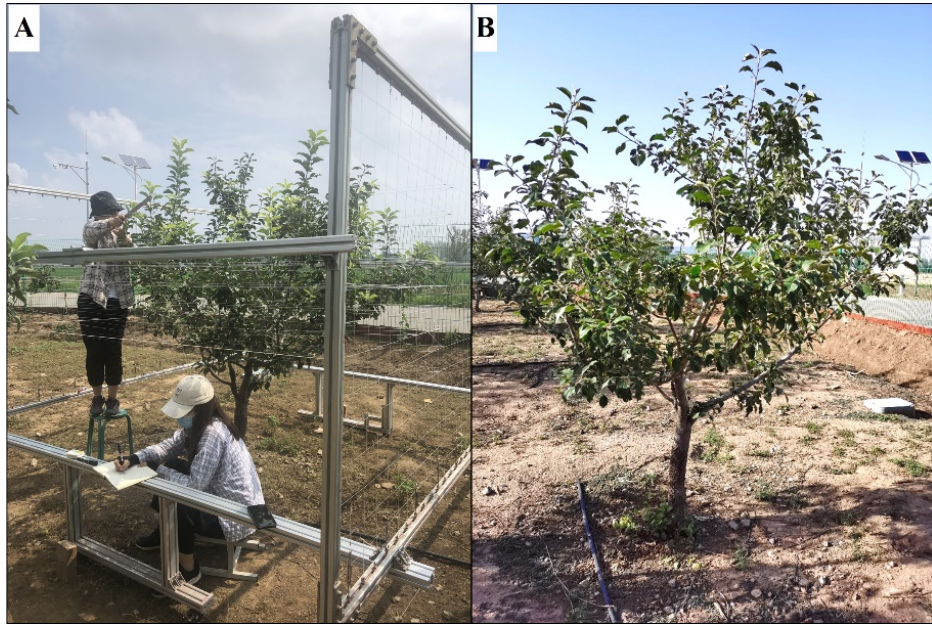
Figure 1. Manual measurement process of canopy leaf area ( A ) and the test orchard tree ( B ).